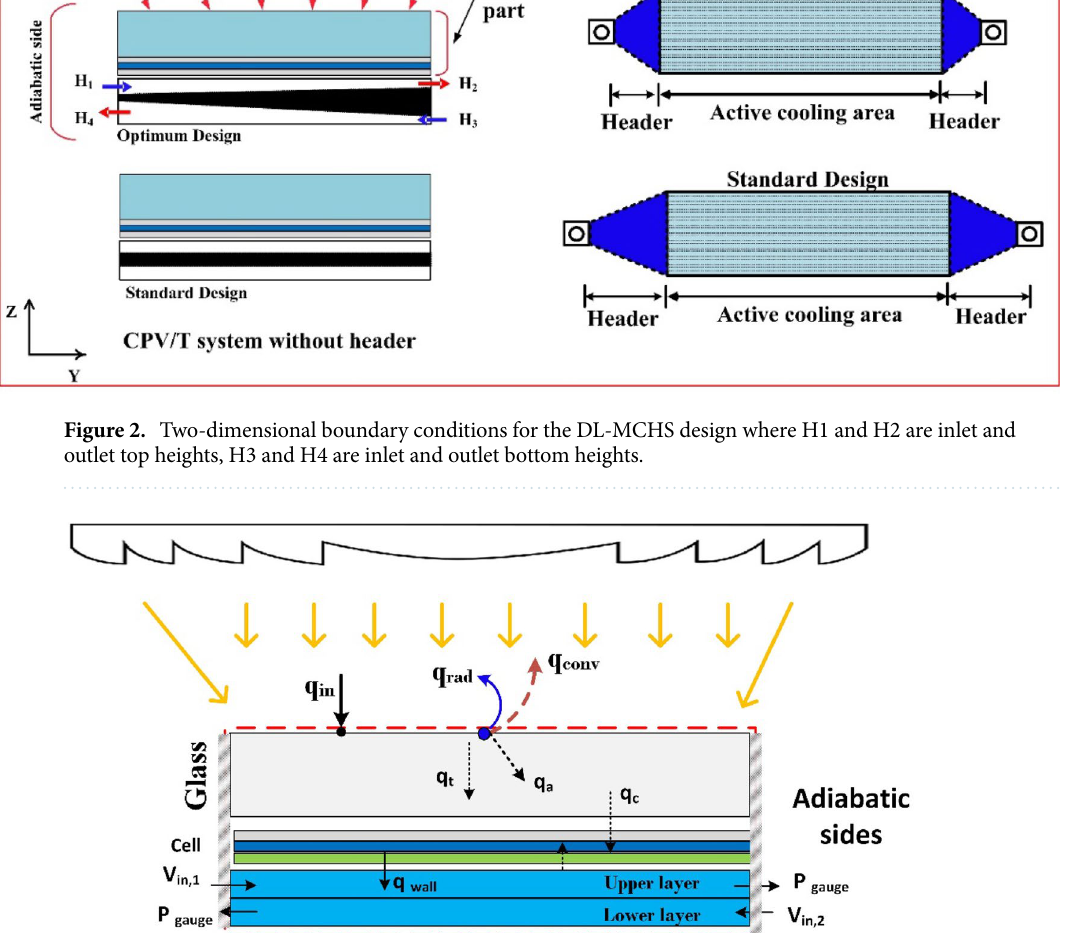
Figure 3. Three-dimensional boundary conditions for the CPV/T